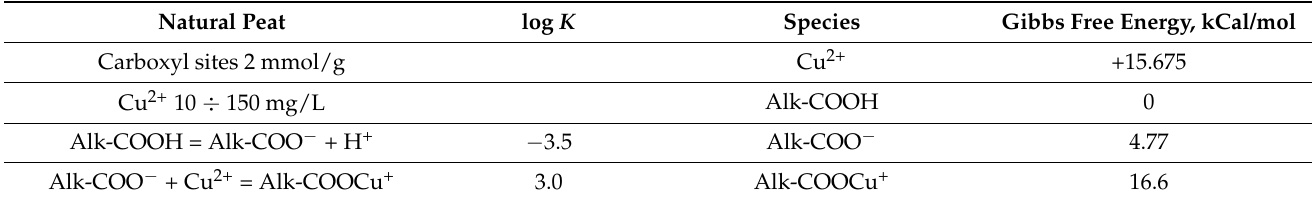
Table 6. Retention parameters of the organic component of peat towards Cu 2+ .